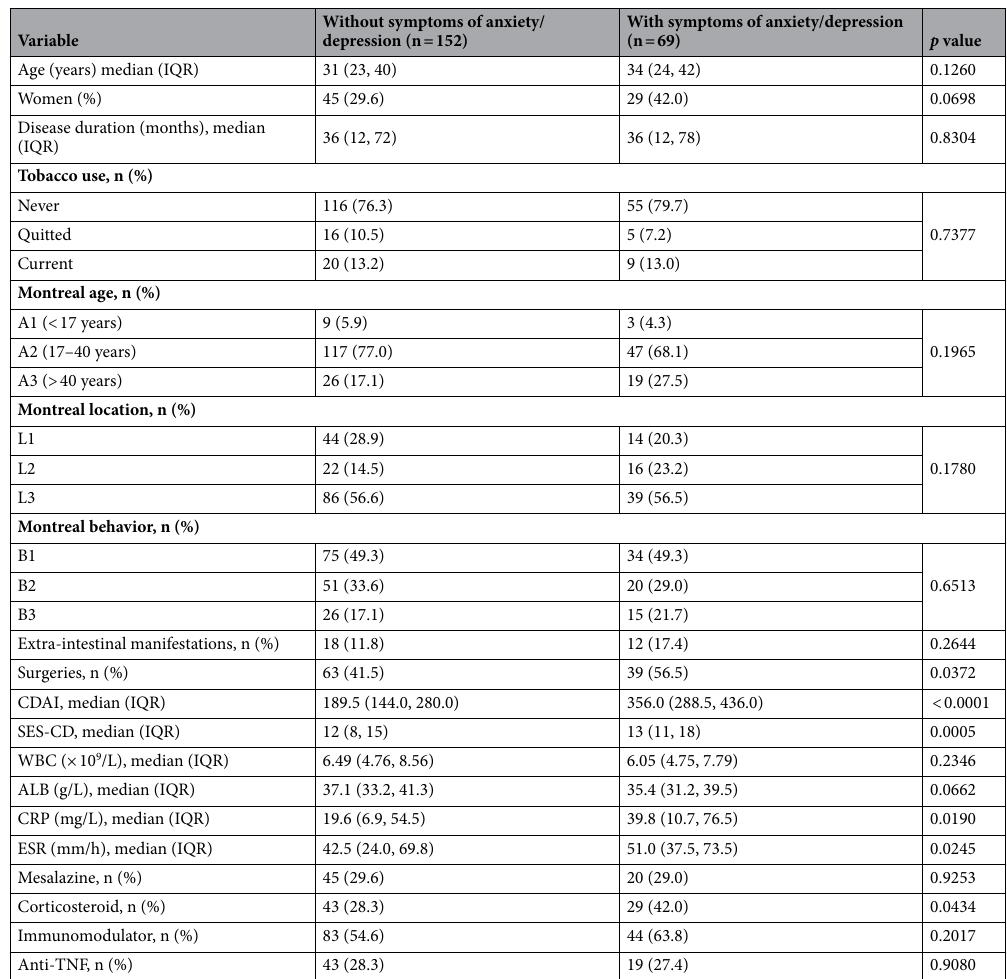
Table 2. Characteristics of the CD cohort. CD Crohn’s disease, CDAI Crohn’s disease activity index, SES-CD Simple Endoscopic Score for Crohn’s disease, WBC white blood count, ALB albumin, ESR